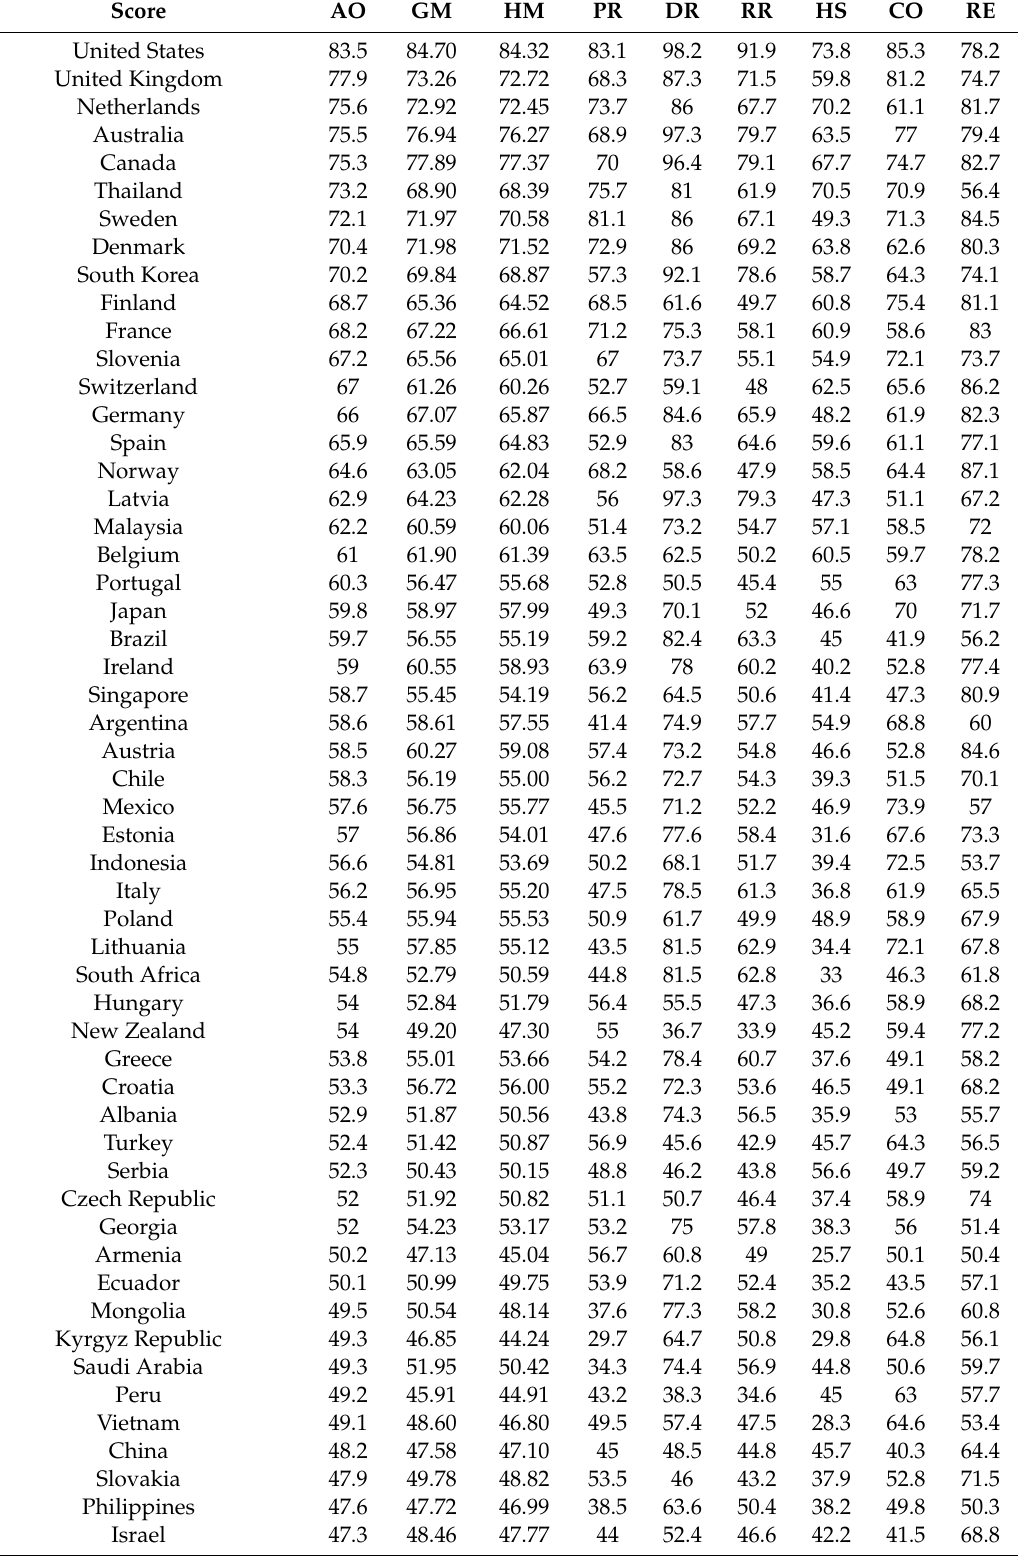
Table A1. GHS Index Numerical Score Rankings for 195